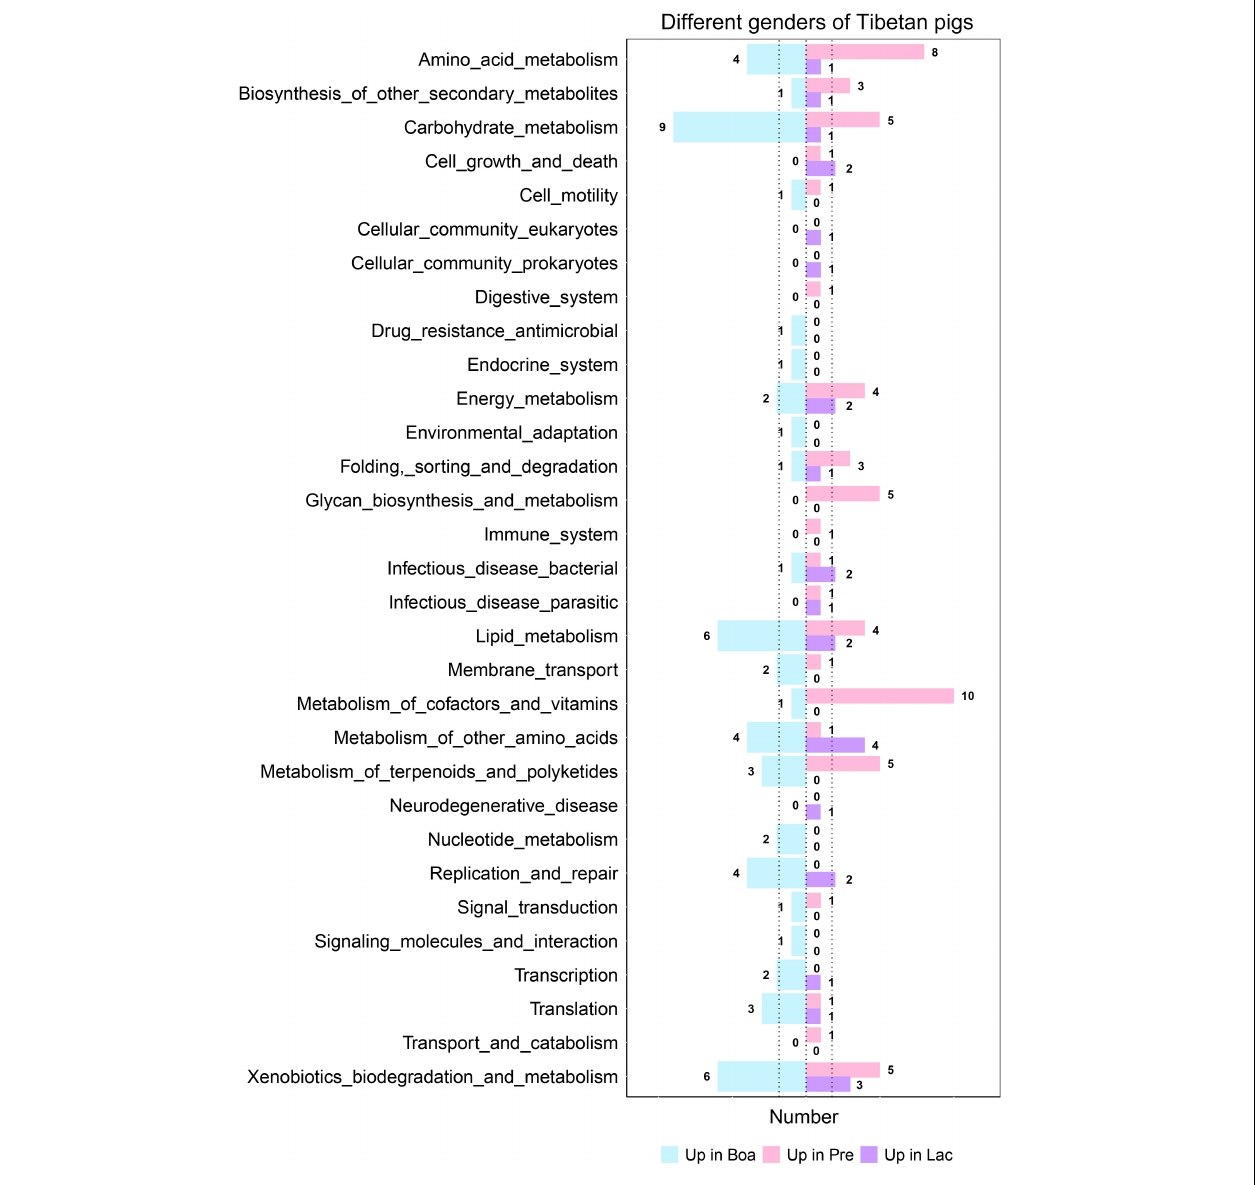
FIGURE 9 | Correlations of gut bacteria in boars, and pregnant and lactating sows to each level 3 KEGG pathway. The figure shows the number of pathways with the most significant correlation among the three groups.